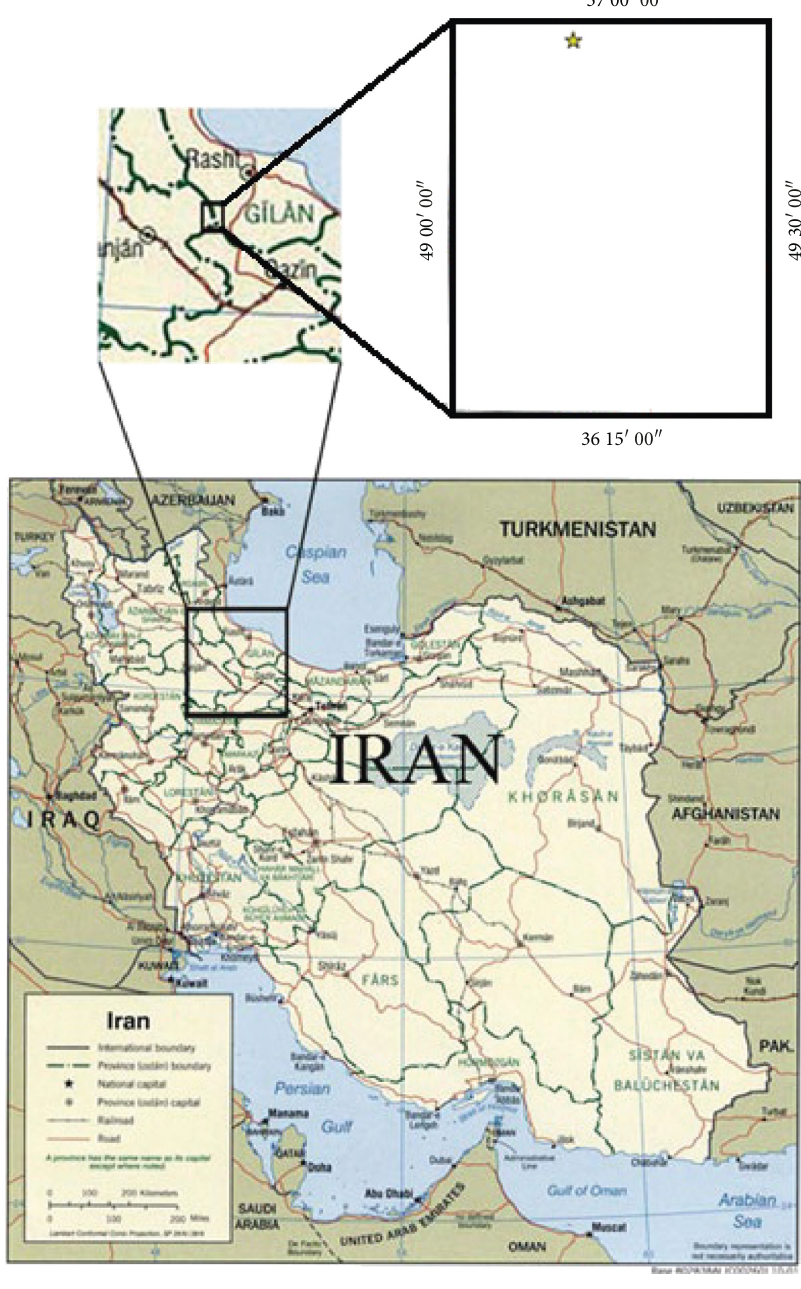
Figure 9: Roudbar quadrangle index map